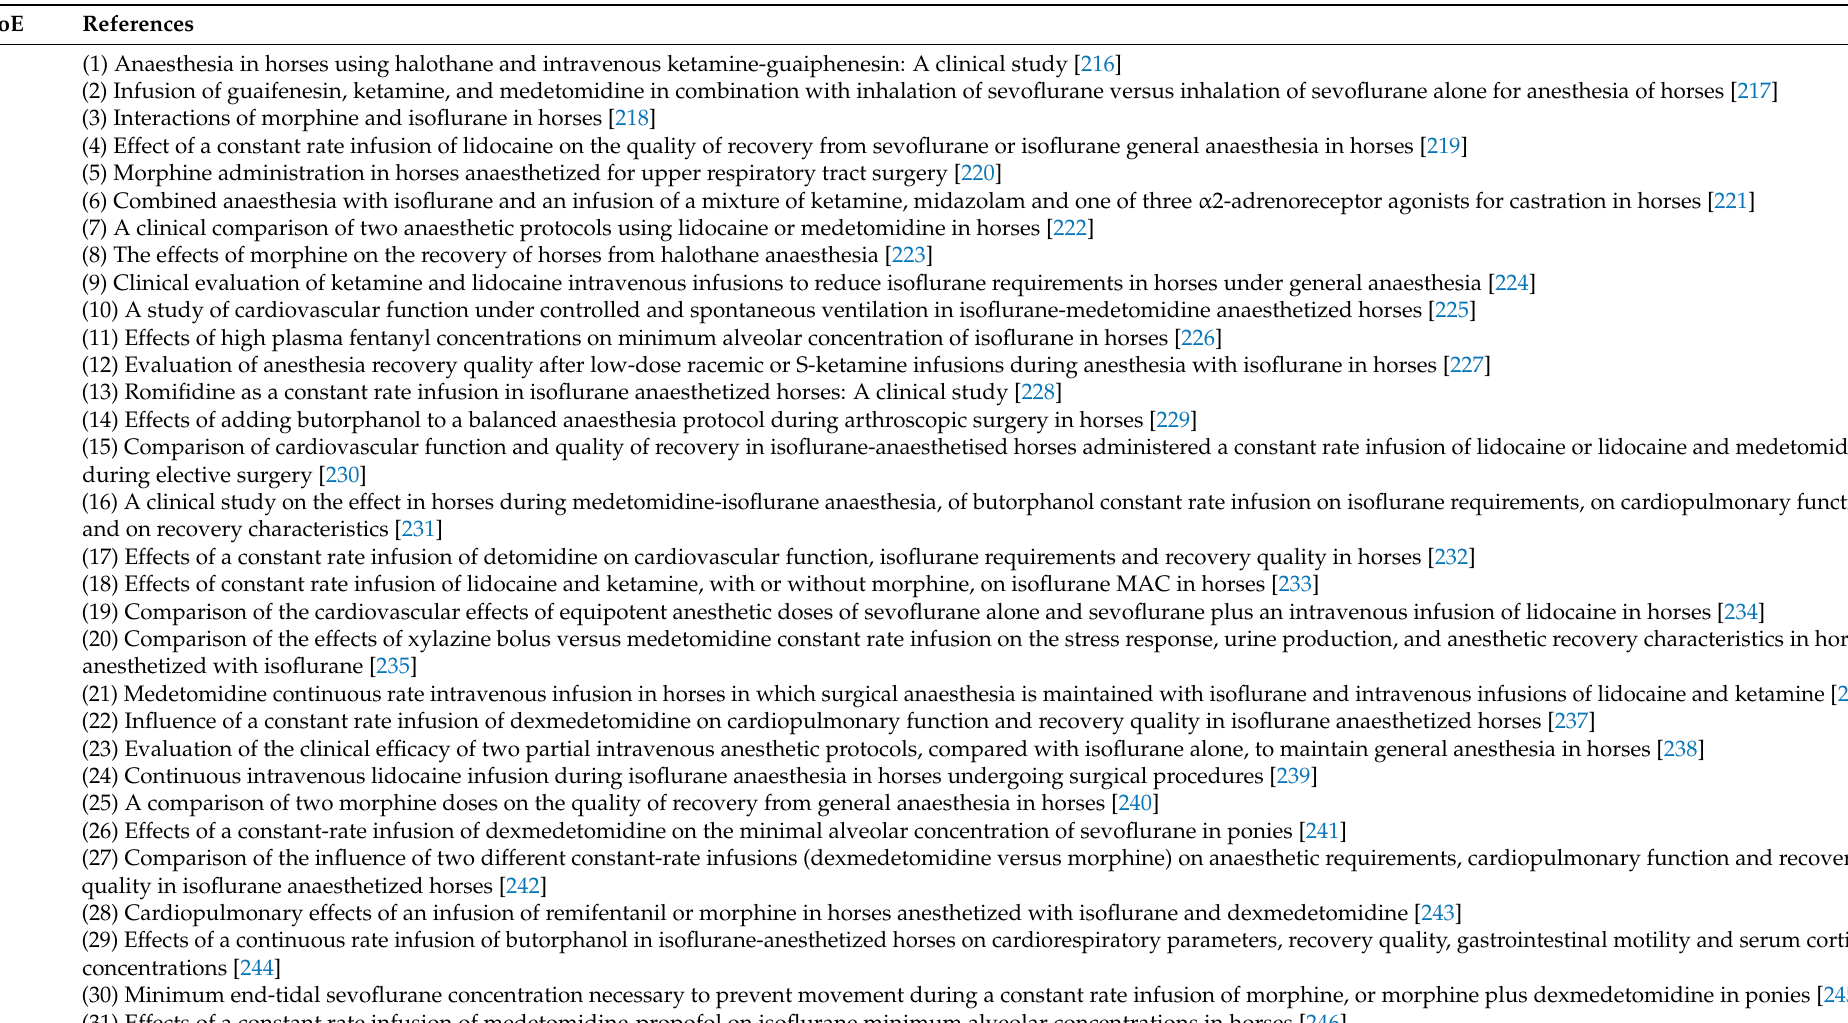
Table 6. Total of publications giving information about the effects of “ maintenance with partial intravenous anaesthesia (PIVA) ” on the recovery